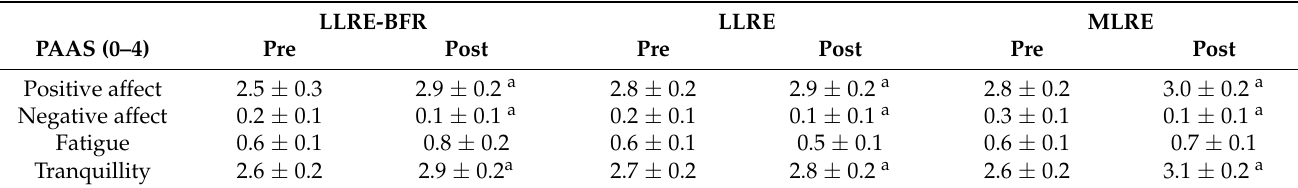
Table 3. Physical Activity Affect Scale measured pre and post exercise session.